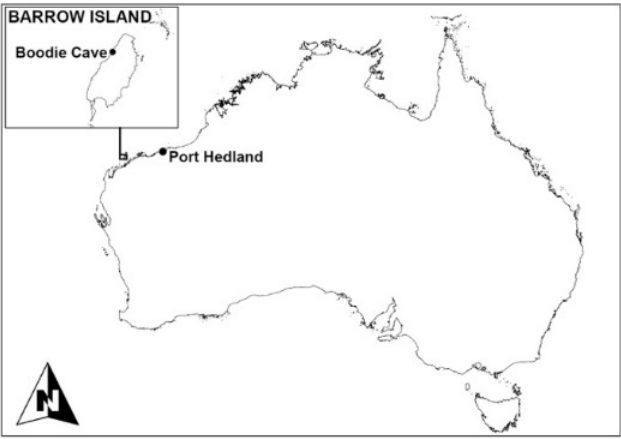
Figure 1. Location of Boodie Cave, Barrow Island, Western Australia.